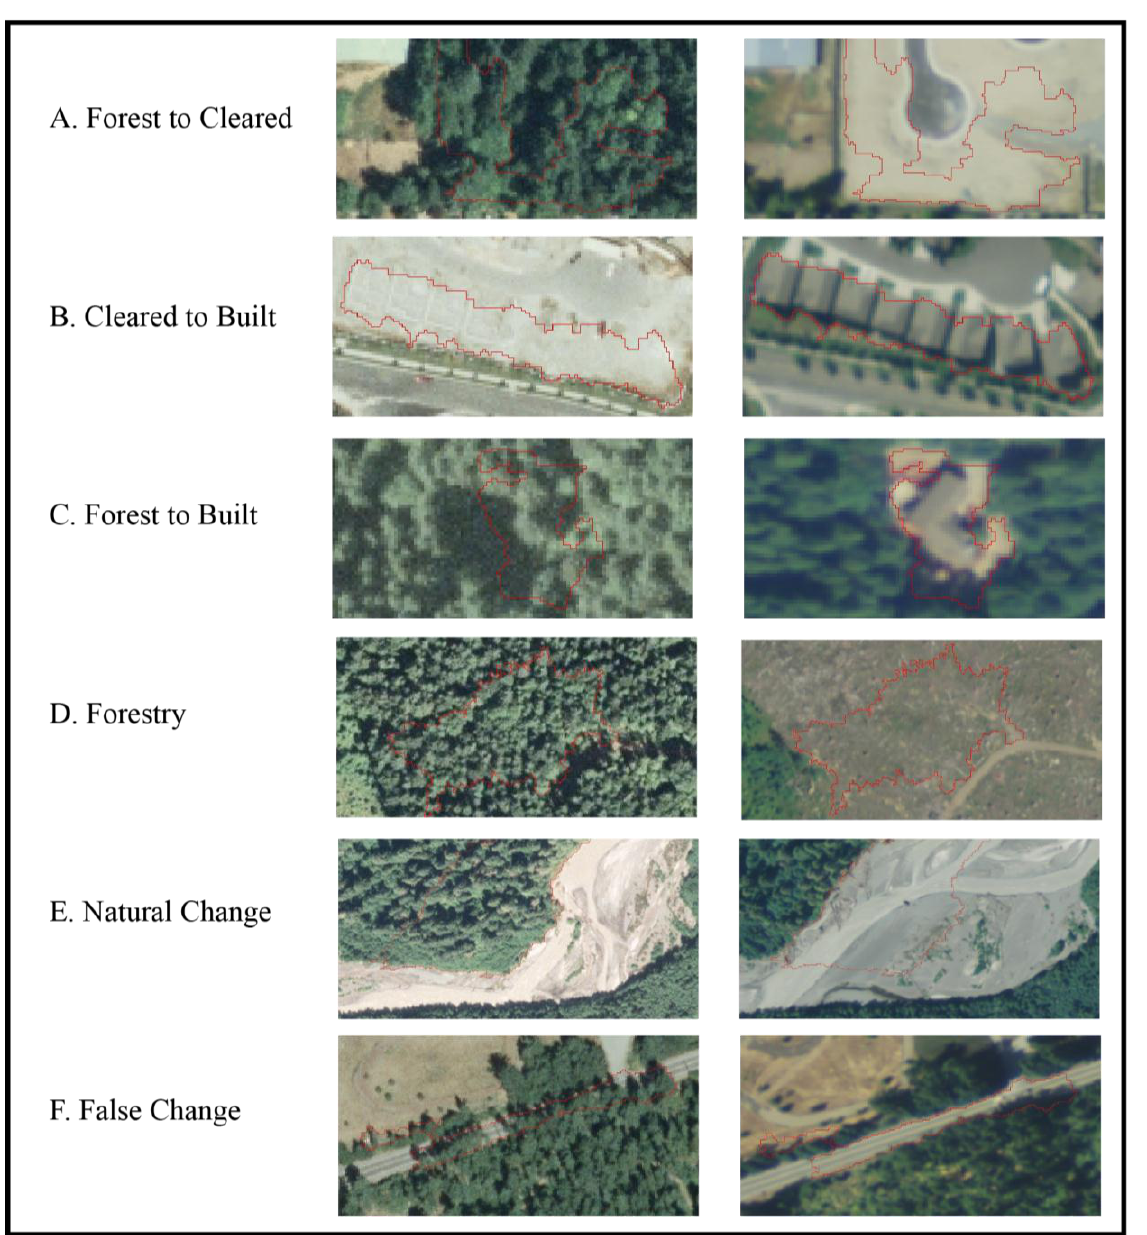
Figure 5. Examples of typical changes included in the training data. Changes like ( A–C ) were labeled as development in the final maps. Changes like ( D ) were labeled forestry. ( E ) Natural changes most commonly are stream course changes, land-slides and fires. ( F ) False changes are due to events like tree lean and shifting shadow